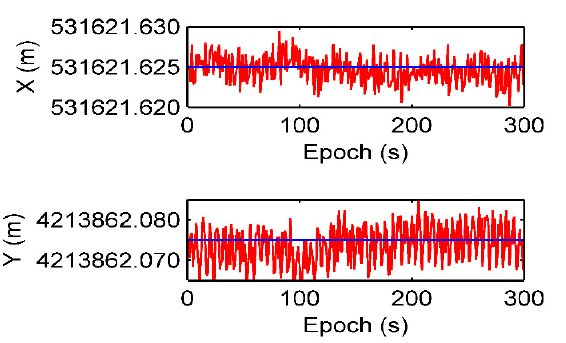
ff erential positioning algorithm in the static test. Sensors 2019 , 19 , 4580